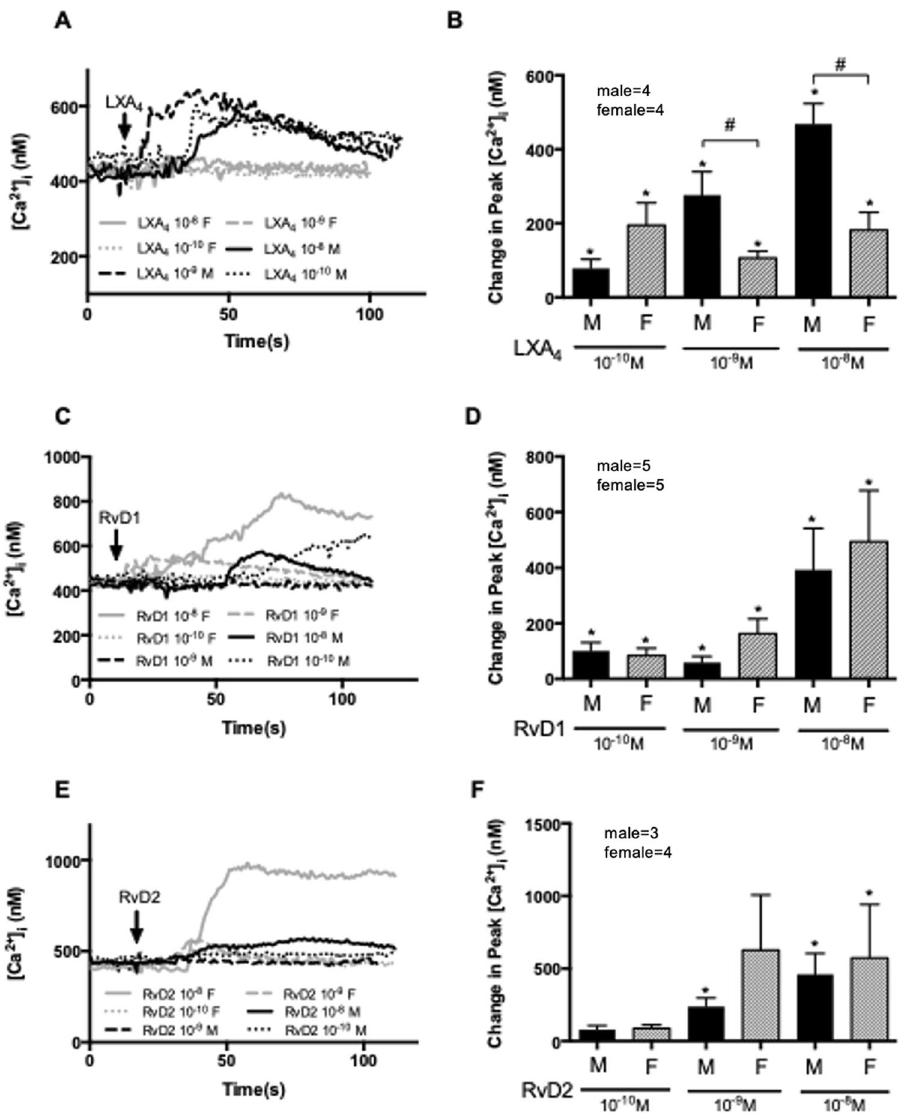
Figure 7. Cultured conjunctival goblet cell Ca 2+ response to LXA 4 from male is greater than female cells. Goblet cells from both sexes were stimulated with LXA 4 10 –10 –10 −8 M ( A and B ) RvD1 10 –10 –10 −8 M (C and D) or RvD2 10 –10 –10 −8 M ( E and F ). [Ca 2+ ] i was measured by fura2 assay. The average [Ca 2+ ] i level over time was shown in ( A , C and E ). Change in peak [Ca 2+ ] i was calculated and shown in ( B , D and F ). Data are mean ± SEM, the number of individuals is marked in each graph. Arrow indicates the addition of stimuli. Black lines and solid bars indicate data from male cells. Grey lines and slash-patterned bars and indicate data from female cells. *Significance difference from basal. # Significance difference between males and